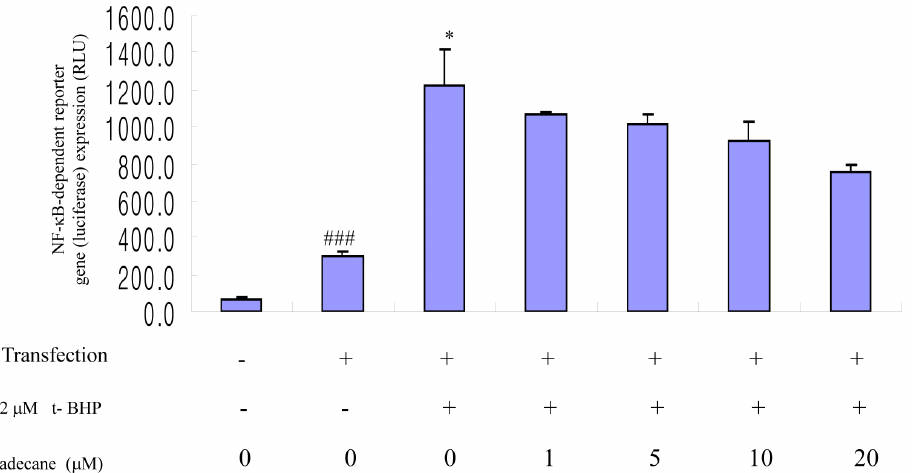
Figure 5. Heptadecane inhibited oxidative stress-induced NF-kB-dependent reporter gene (luciferase) expression. YPEN-1 cells were transiently transfected with a NF-kB-containing plasmid linked to the luciferase gene, then pre-incubation with heptadecane (1, 5, 10 m M and 20 m M) for 1 hr and co-treated with t-BHP for 5 hr. Results are presented in relative luminescence units (RLU). One-way analysis of variance (ANOVA) was used to determine the significances of NF-kB-dependent luciferase activity differences between untreated controls and treated groups: ## p , 0.01 vs. vector control, *p , 0.05 vs. treated 0.2 m M t-BHP group, respectively.